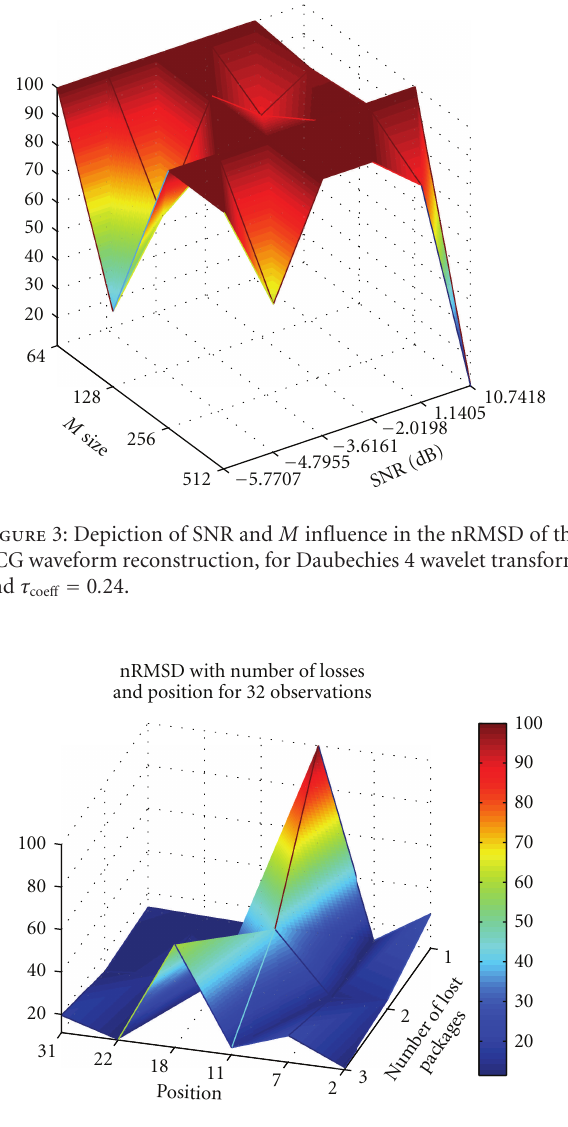
Figure 6: PPG nRMSD dependence on wavelet transform and number of packets lost, for τ coe ff = 0 .